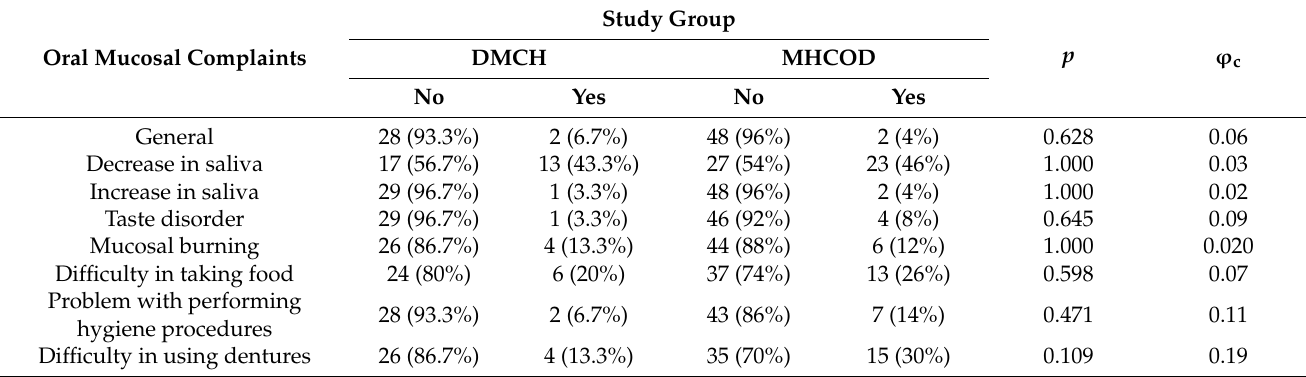
Table 2. The frequency of oral mucosal complaints in both